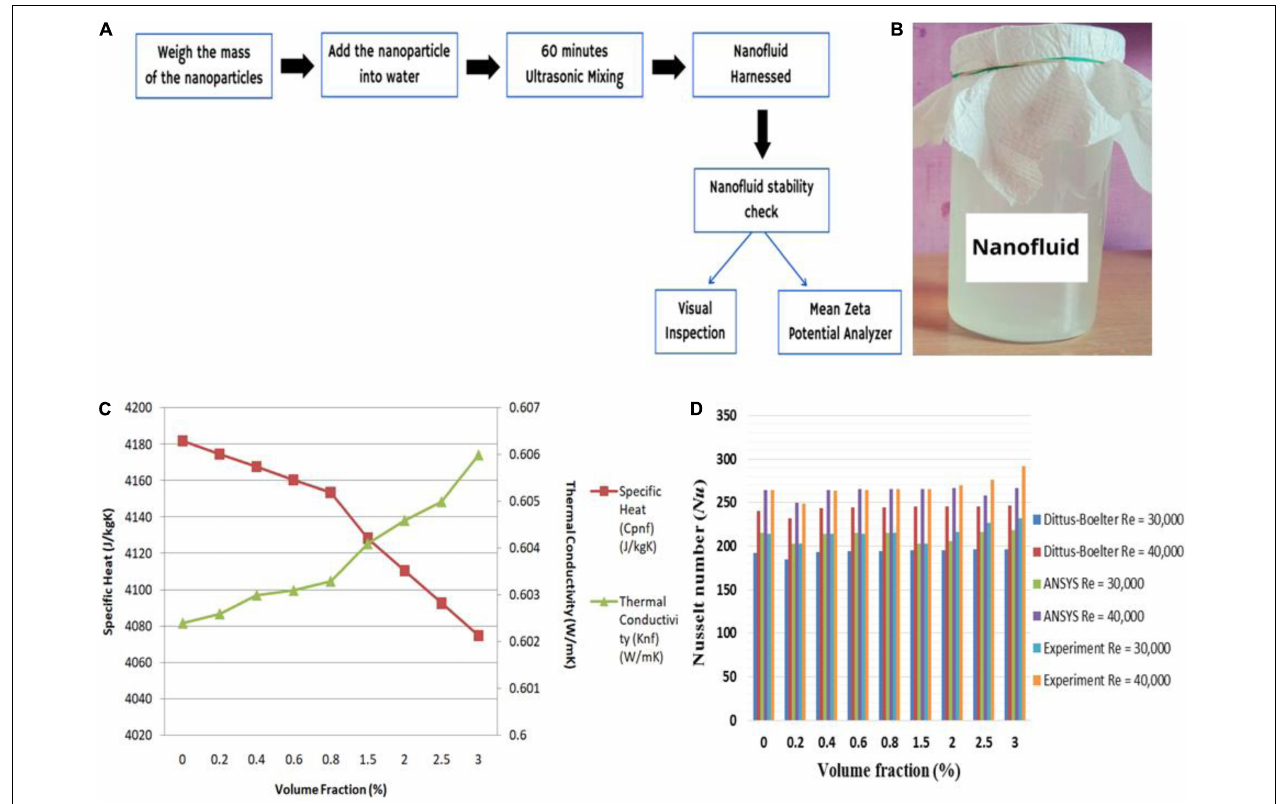
FIGURE 1 | Development of organic nanofluid by Majumder and Das (2020) - (A) Processes involved in developing and checking the stability of the nanofluid, (B) Visual of the developed nanofluid. (C) Variation of specific heat and thermal conductivity with an increase in the volume fraction of the nanoparticle, and (D) Variation of Nusselt number with an increase in the volume fraction of the nanoparticle.